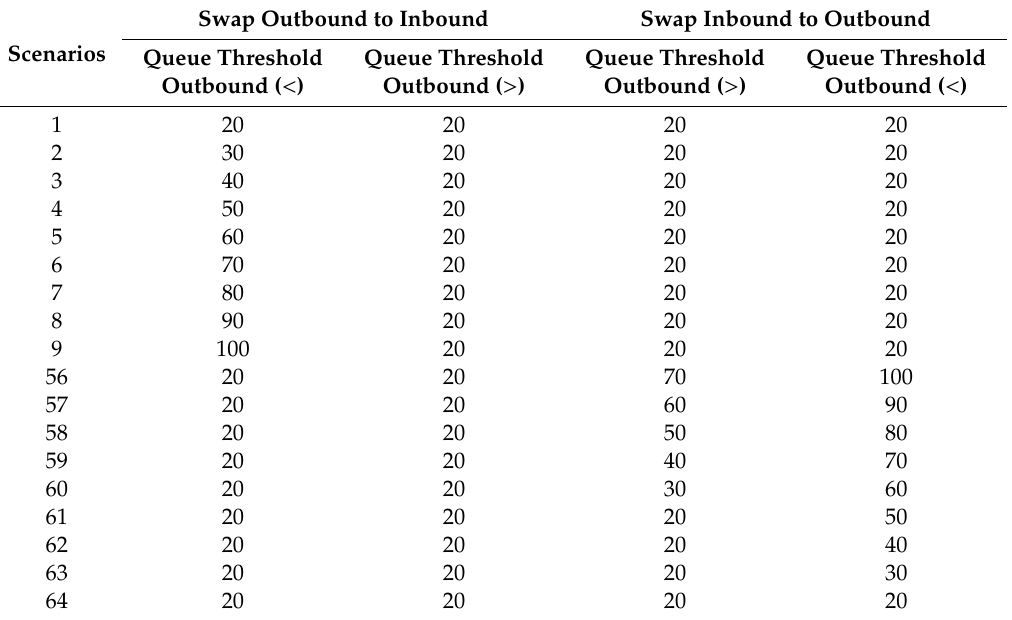
Figure 10. Outcomes of simulated immigration staff sharing rules. Table 2. Summary of eligible sharing